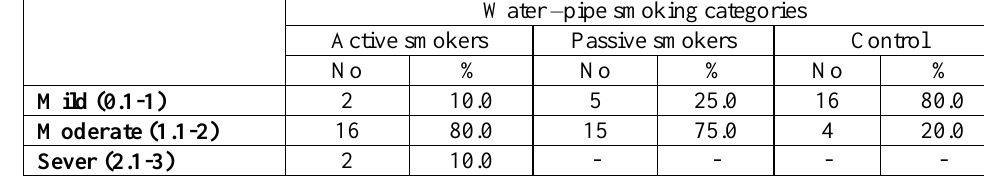
Table 4: distribution of water-pipe smokers and the control groups according to severity of